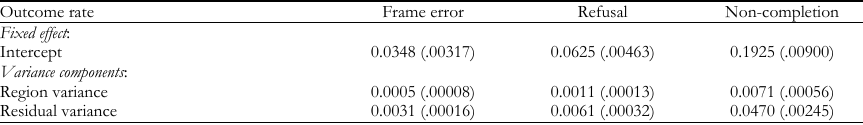
Null model for frame error, refusal and non-completion rates: solutions for fixed and random effects – 2004 Outcome rate